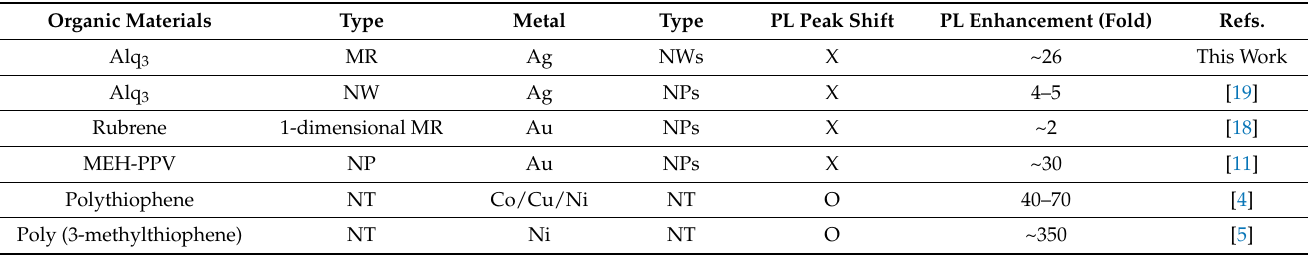
Table 1. Comparison of the structural characteristics and typical PL features in the various hybrid organic/metal